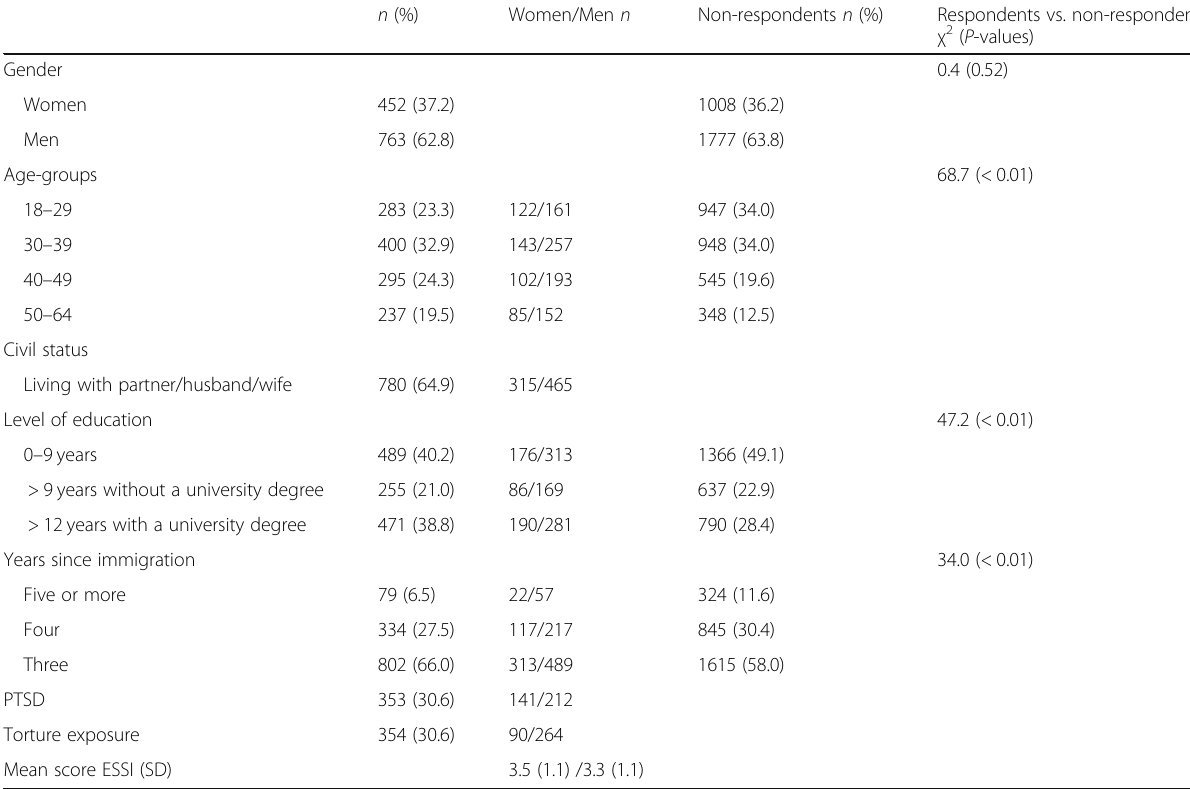
Table 1 Sociodemographic characteristics of the respondents ( n = 1215) supplemented with non-response